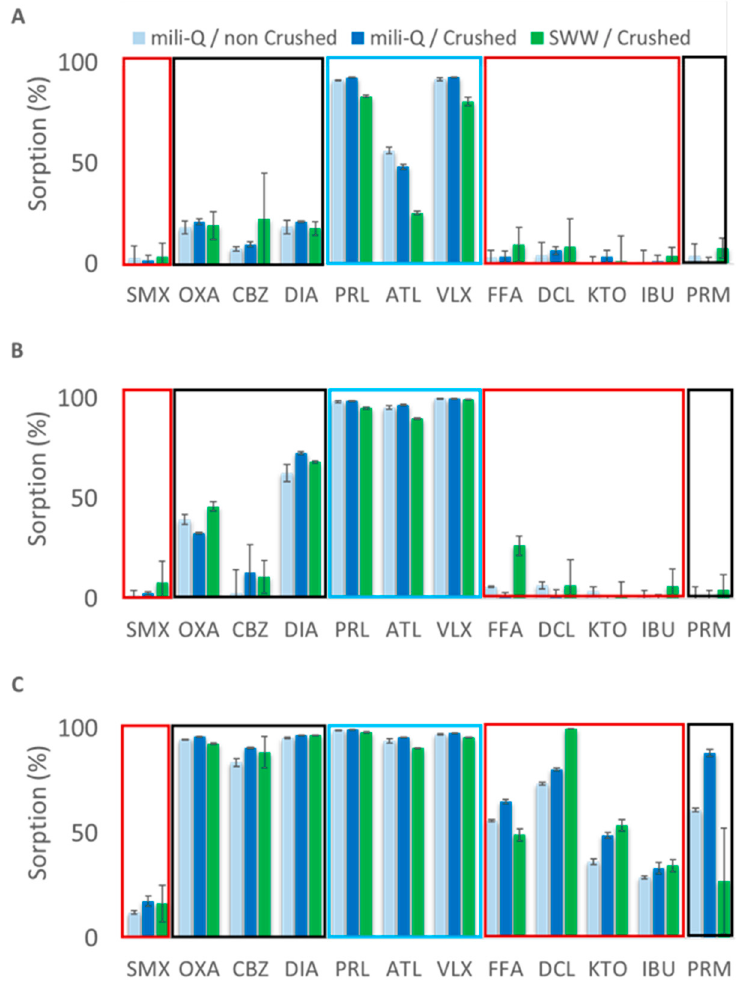
Figure 2. Sorption on sand ( A ), clay ( B ), and compost ( C ) calculated from batch experiment with 60 min contact time, 1:3 solid: water ratio, non-crushed materials in milli Q-water (pale blue), crushed materials in milli Q-water (dark blue), and crushed materials in SWW (green). Variability in the triplicates is displayed as error bars. PhACs with dominant neutral, anionic, and cationic fractions are grouped in black, red, and blue squares, respectively.